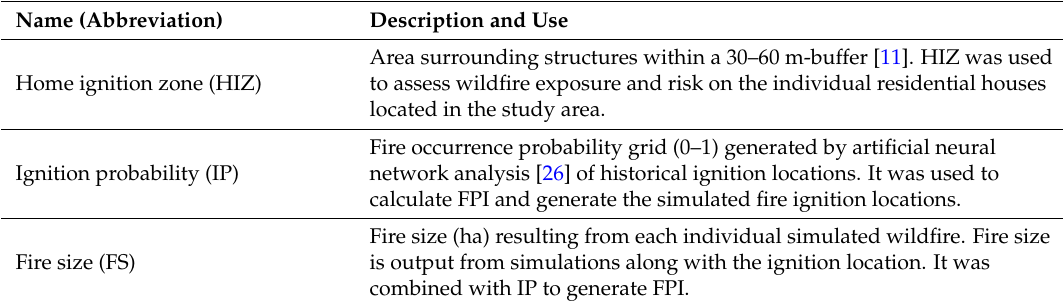
Figure 2. Wildfire simulation and analysis process summary flowchart. Wildfire simulation requires fire weather, landscape and fire ignition input data. Fire initiation, transmission, exposure and risk analysis use different fire modeling outputs. Exposure and risk analyses were conducted at individual structure HIZ level. Results were presented in maps or graphics. See Table 1 for the abbreviations. Table 1. Summary table with the abbreviations used in this study for the main geospatial inputs, modeling outcomes and analysis results. The terms are described and contextualized for the use in this study. We provide further details in the following